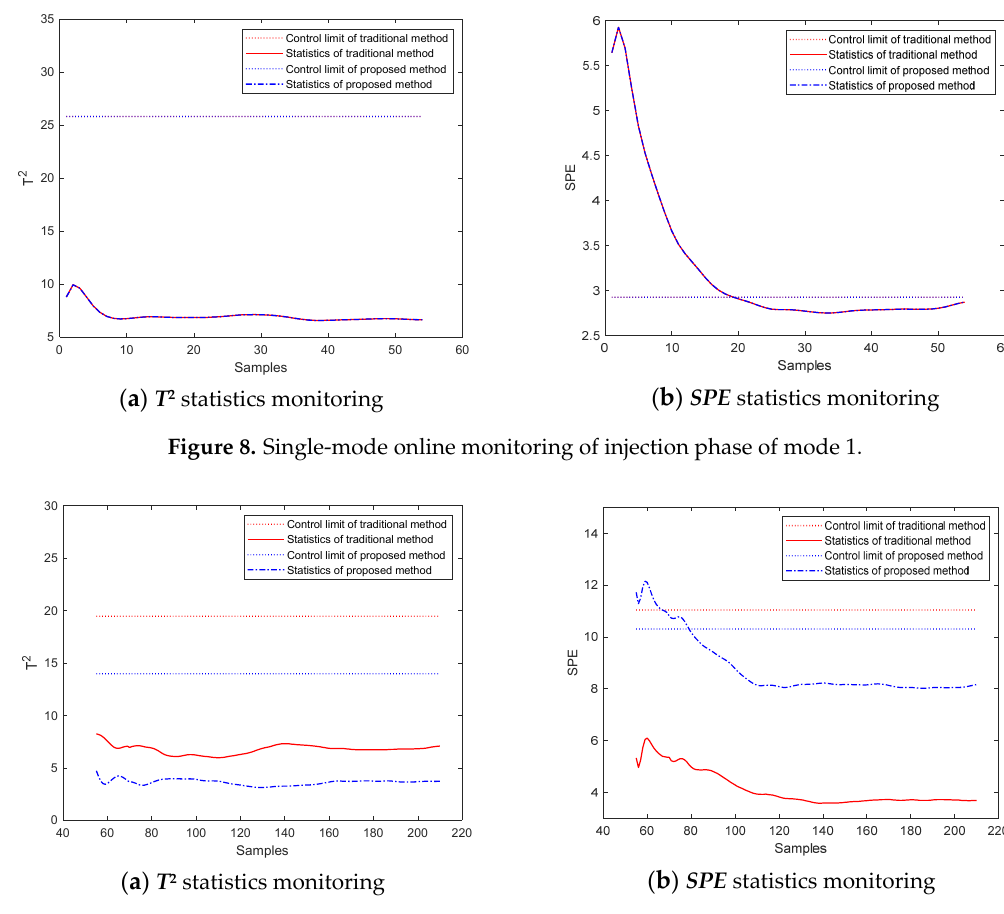
Figure 7. Single-mode online prediction of mode 1.